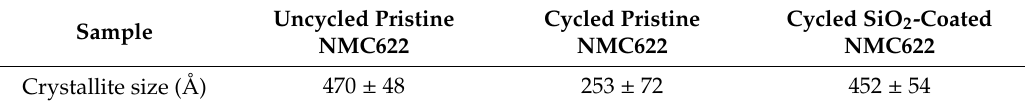
Figure 9. Ex-situ XRD of the pristine and SiO 2 -coated NMC622 electrodes after 700 cycles. Table 4. The crystallite size obtained by calculation of full width of half maximum (FWHM).